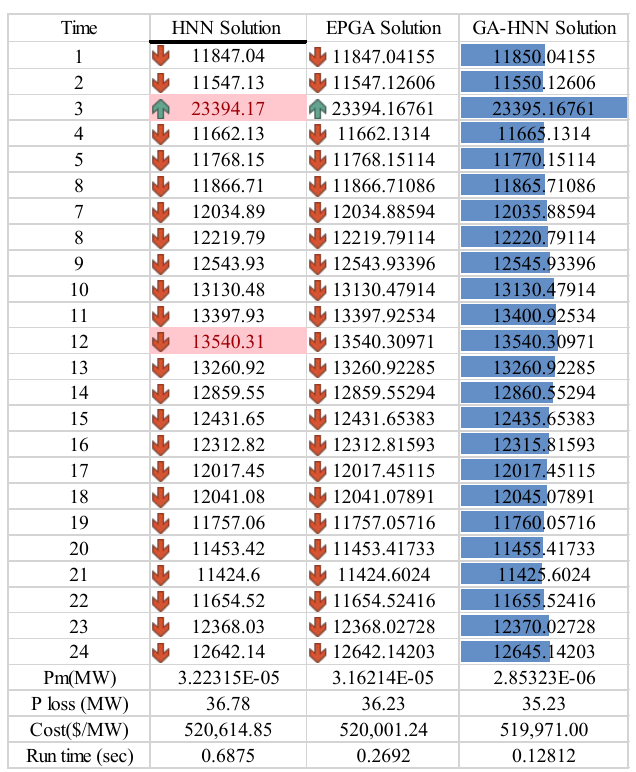
Table 1. Multi-variable multi-objective simulation comparisons of HNN, EPGA, and GA-HNN